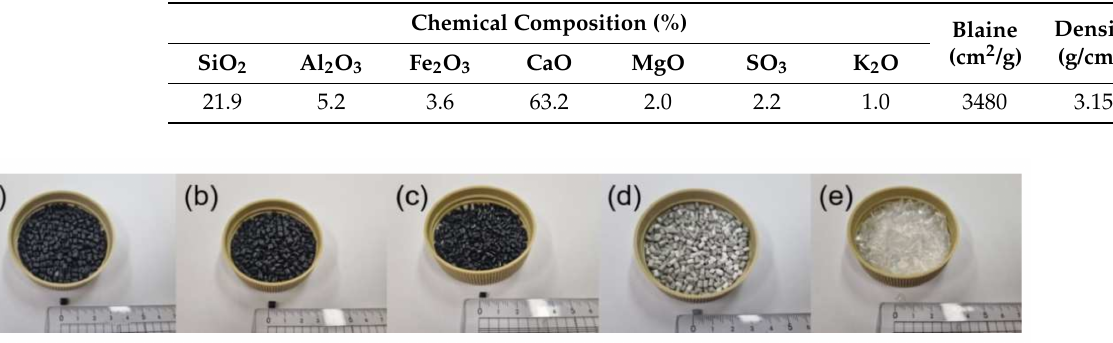
Figure 6. Plastics for gamma irradiation and cement composite: ( a ) PP; ( b ) PE; ( c ) PC; ( d ) ABS; ( e ) PET.